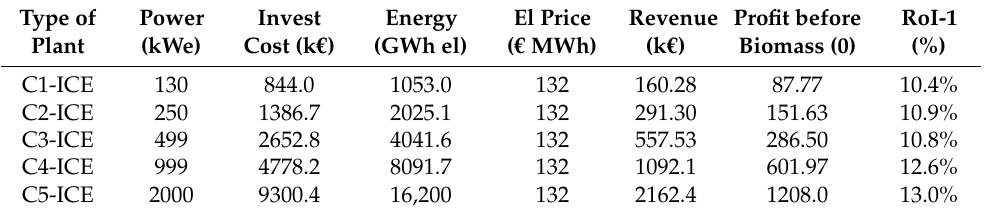
Table 3. Return on investment for selected technologies, plant size and price (Scenario 1).